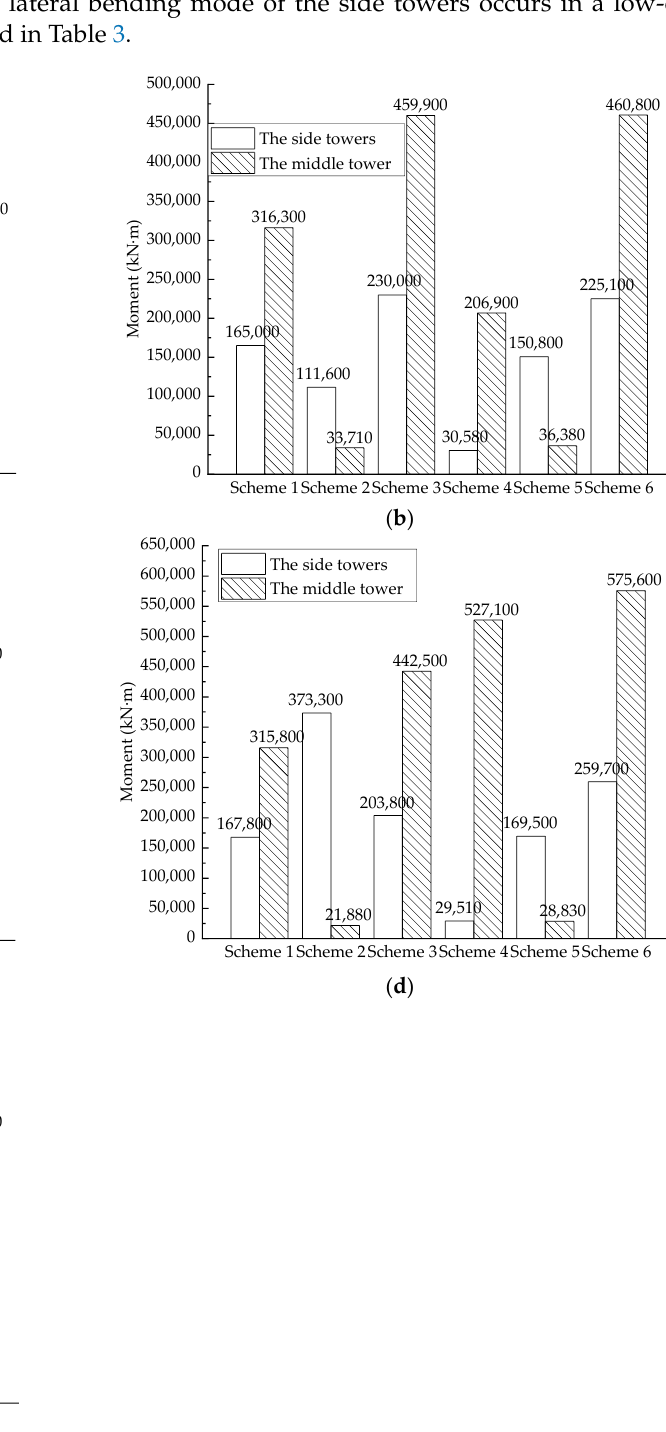
Figure 10. Comparison of the transverse tower shaft moment with different layout schemes of the buffer. ( a ) San Fernando Pacoima Dam record; ( b ) Whittier Narrows-01 record; ( c ) Taft Lincoln School record; ( d ) El Centro Site record; ( e ) MtCarmel-2008-0418a record.